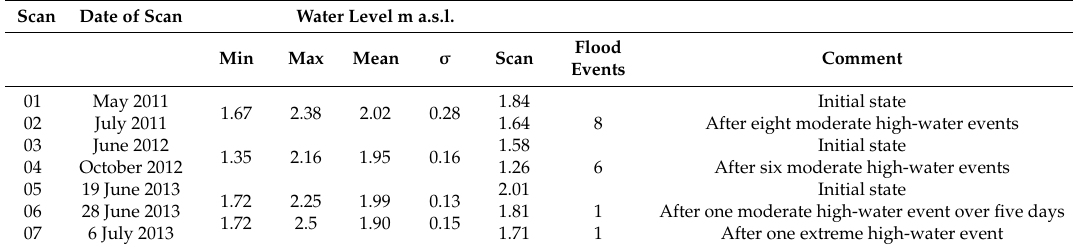
Table 1. Overview of scans and water level